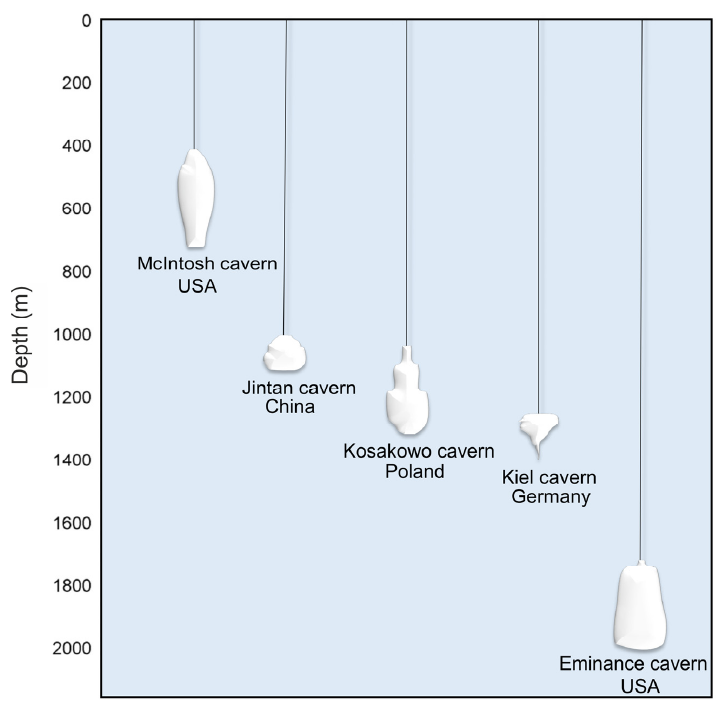
Figure 3. Examples of different shapes of salt caverns across the world.